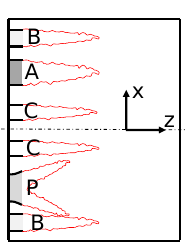
Figure 2. Sketch of the combustor side view.